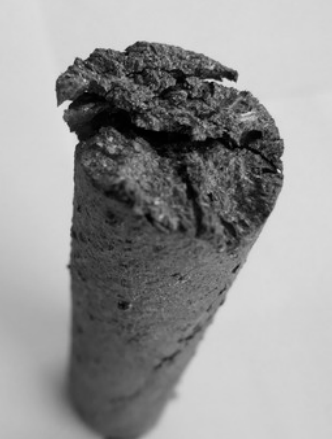
Figure 13. The sample without heat-treatment, one year after production—visible surface disintegration of structure.